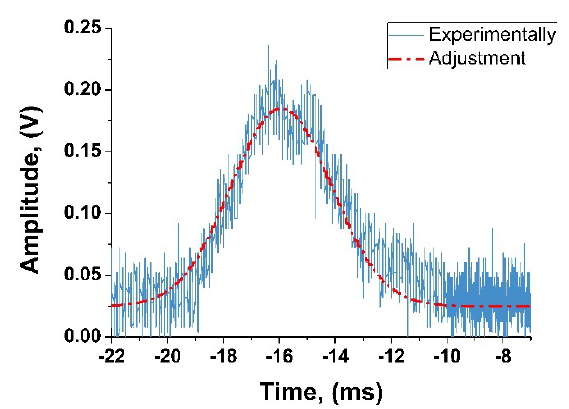
Figure 3. Adjustment of the pulse in the input signal of the lock-in using a Gaussian function.